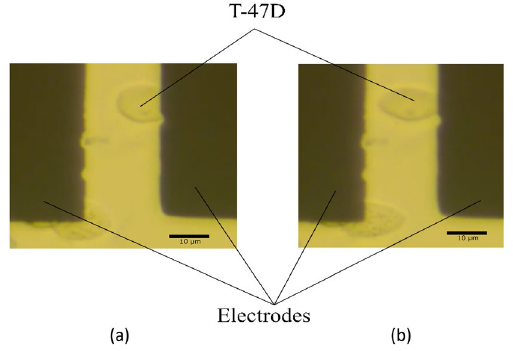
Figure 7. Elongation of T-47D in an electrical field is shown for different times ( a ) T = 0 s ( b ) T = 105